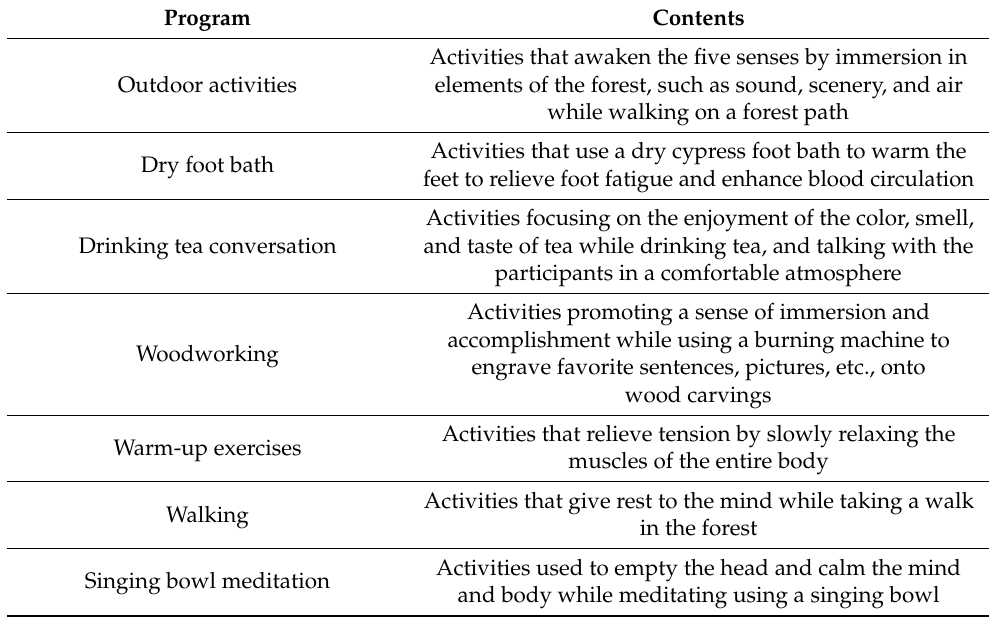
Table 1. Descriptions of the Forest Healing Program elements.